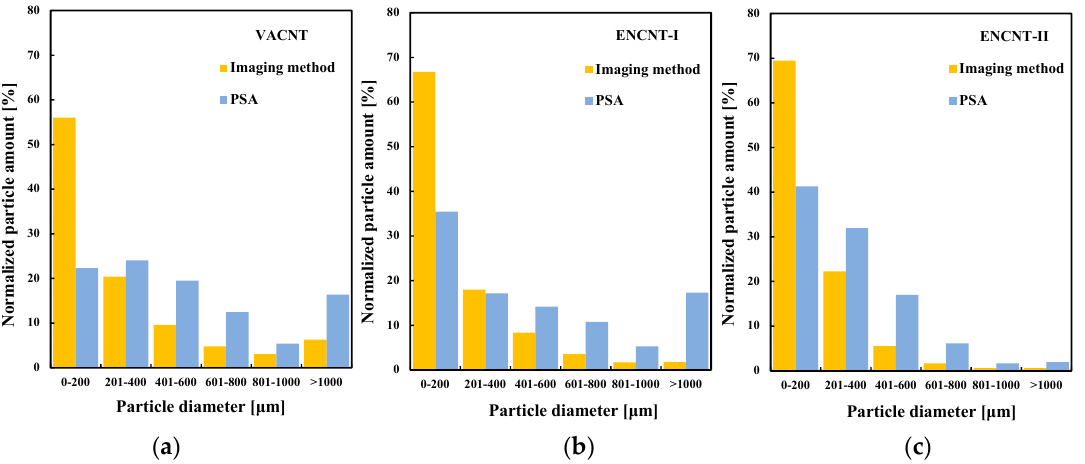
Figure 6. Comparison of particle size distributions from image method and particle size analyzer ( a , b , c ) (PSA: Laser diffraction method).